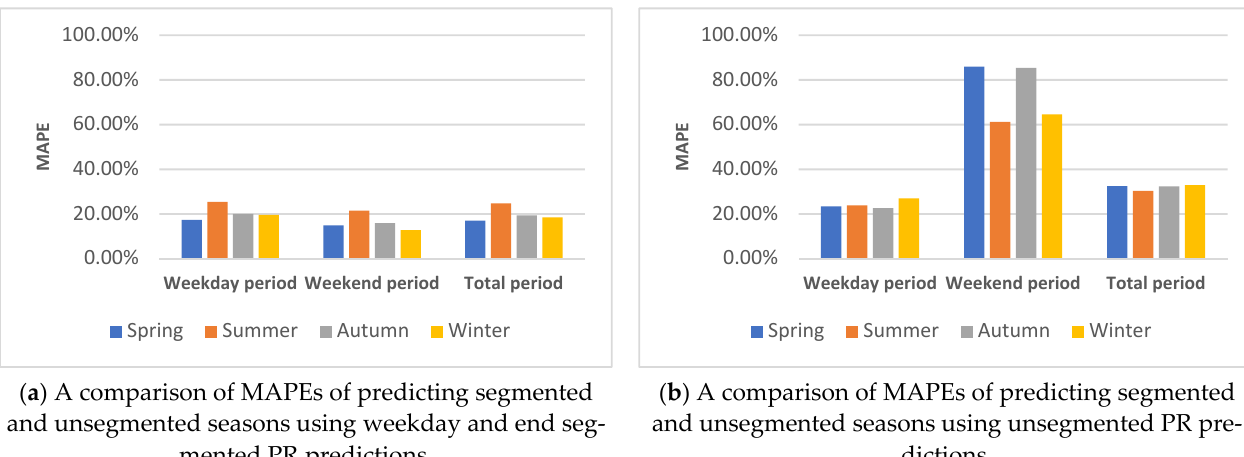
( b ) A comparison of MAPEs of predicting segmented and unsegmented seasons using unsegmented PR pre- dictions. Figure 11. A comparison of weekday and weekend segmented and non-segmented PR prediction’s MAPEs.